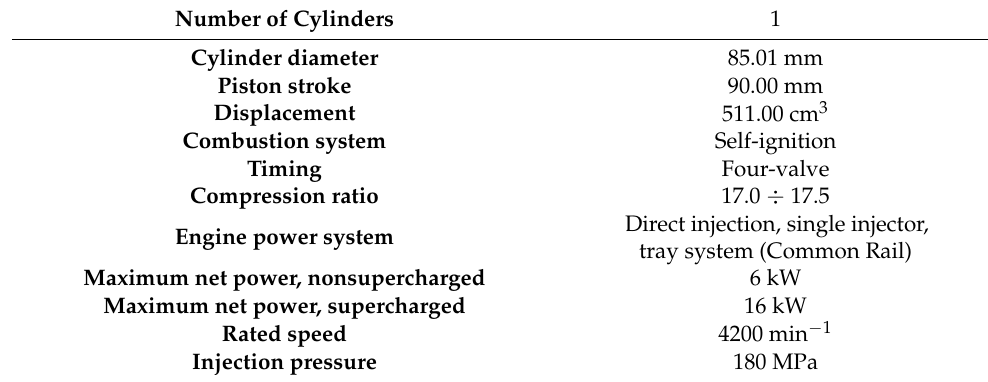
Table 1. Basic information on the AVL 5402